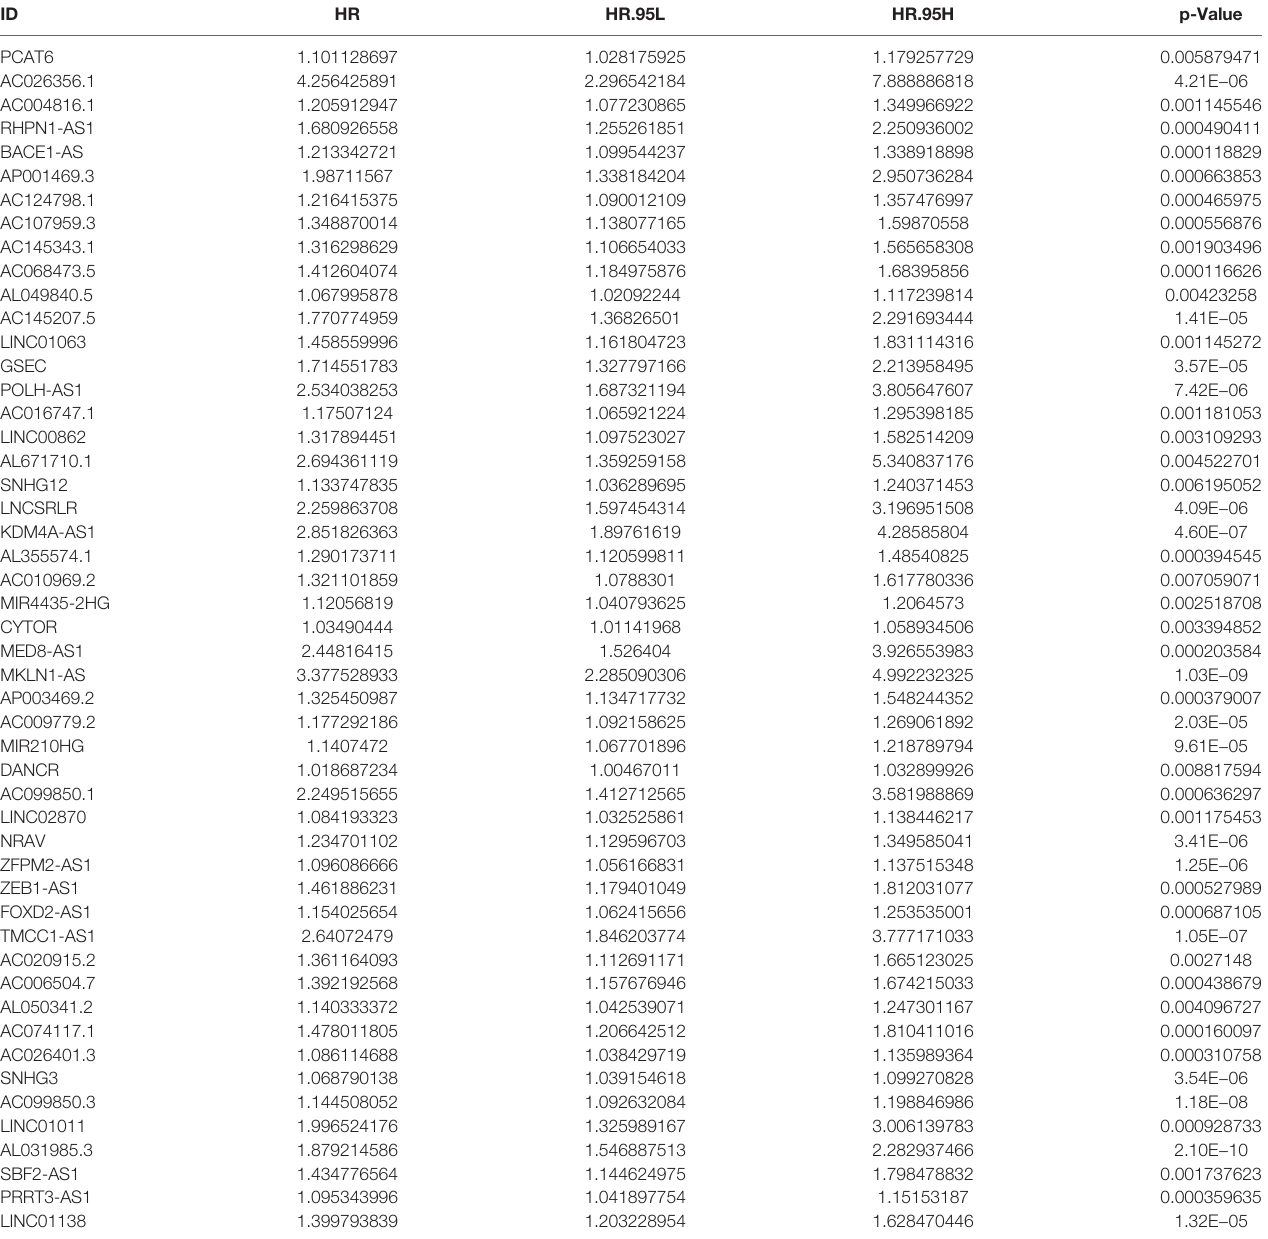
TABLE 2 | Prognostic ferroptosis-related lncRNAs identi fi ed via univariate cox regression